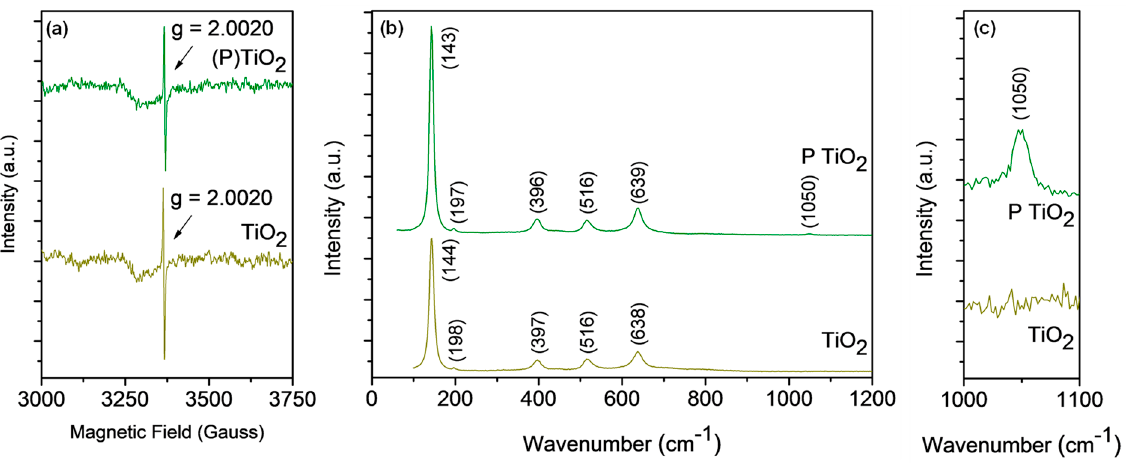
Figure 1. ( a ) EPR spectra of TiO 2 and plasma-treated TiO 2 ((P)TiO 2 ); Raman spectra of TiO 2 and (P)TiO 2 ( b ) 0 − 1200 cm − 1 and ( c ) magnified spectra at 1000 − 1100 cm − 1 . P = plasma treated.